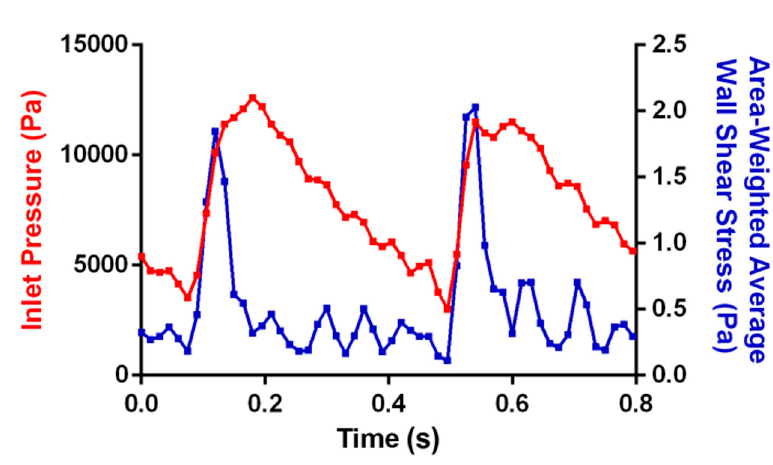
Figure 14. Time evolution of the computational Inlet pressure ( left y-axis ) and Area-Weighted Average Wall Shear Stress ( right y-axis ).